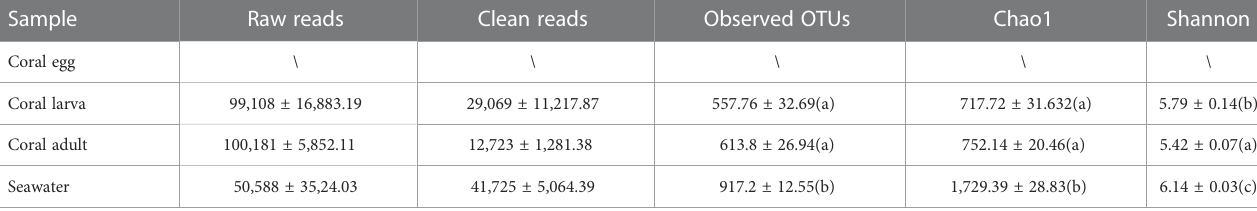
TABLE 1 Alpha diversity of bacteria in coral and the environmental seawater